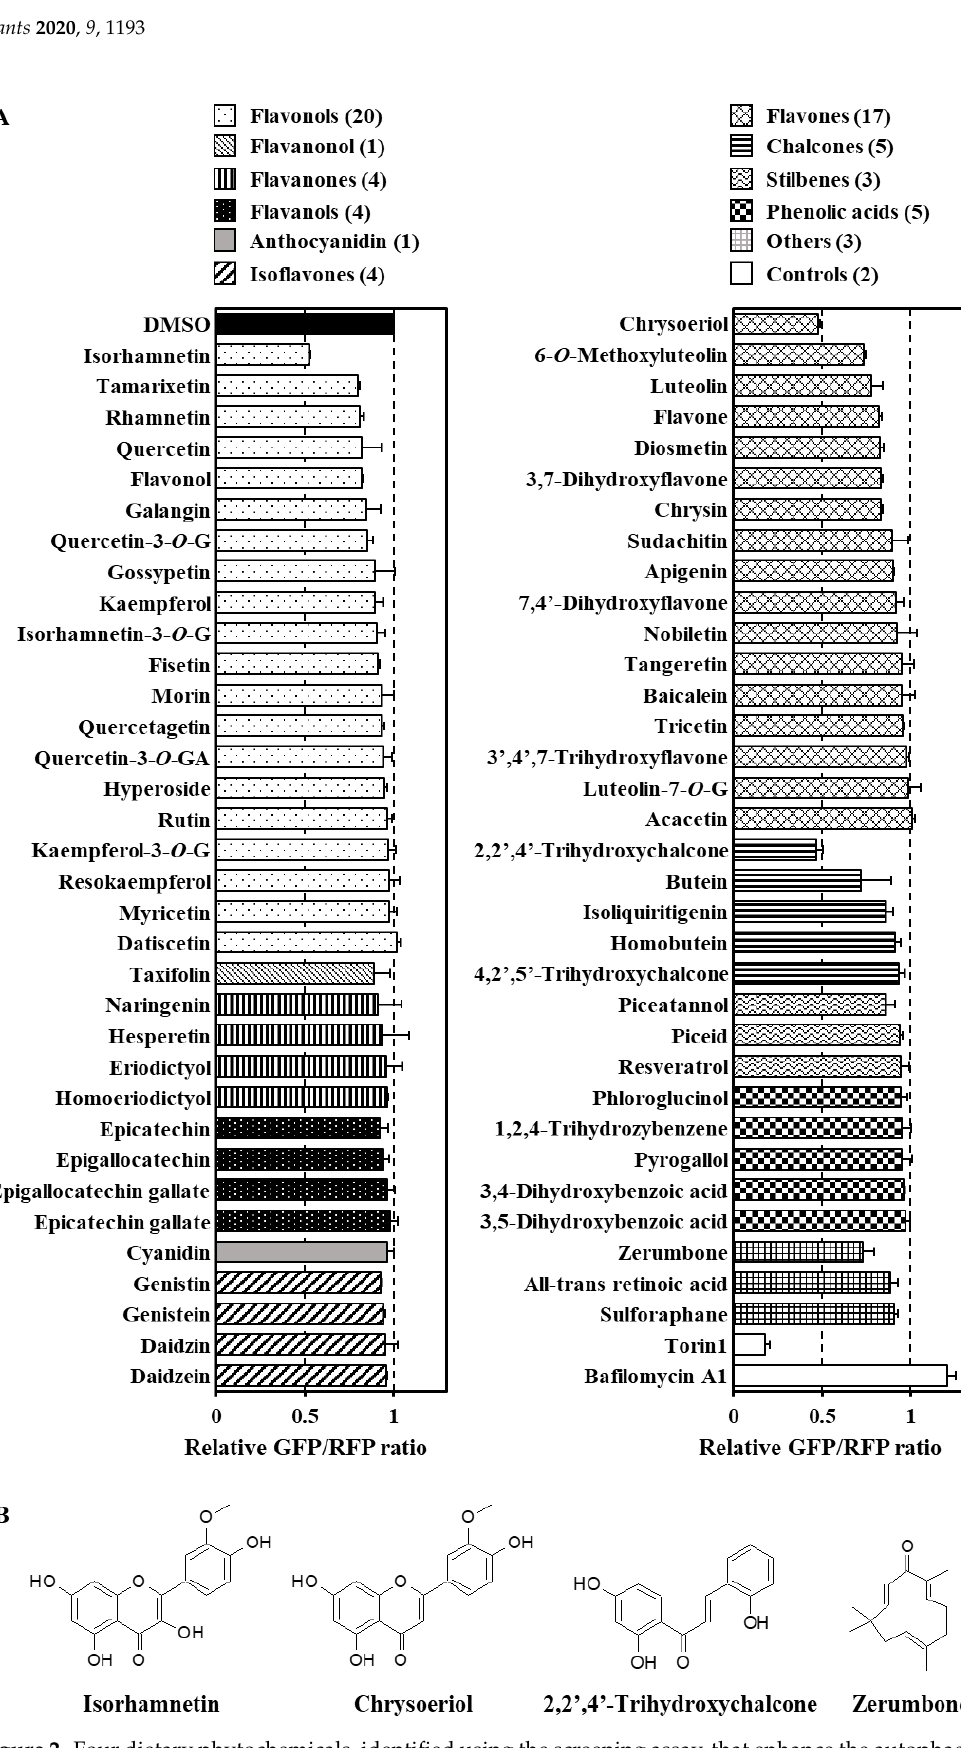
Figure 2. Four dietary phytochemicals, identified using the screening assay, that enhance the autophagy flux. Co-cultured transgenic and wild-type HeLa cells were treated with each phytochemical (10 µ